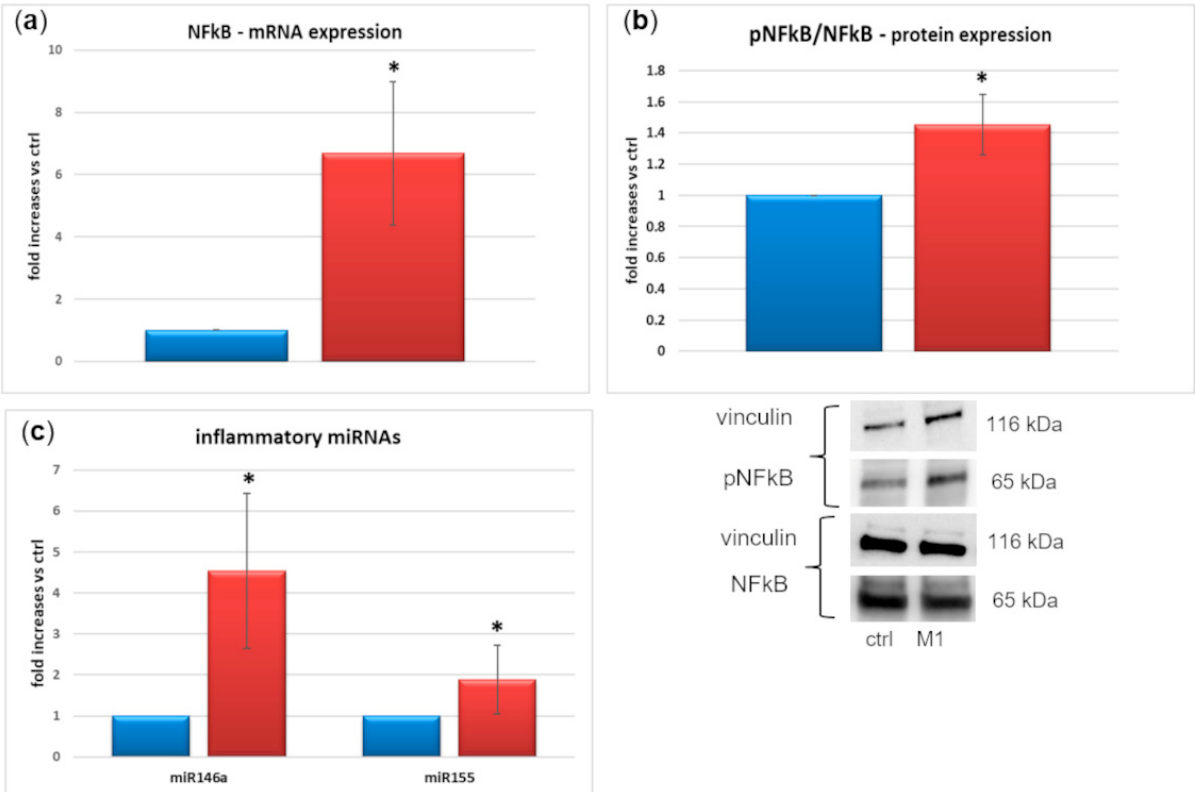
Figure 6. ( a ) Nuclear factor kappa B (NFkB) mRNA expression, mean of five experiments ±SD, * p < 0.05; ( b ) phospo-NFkB (pNFkB)/NFkB protein expression, mean of five experiments ±SD, * p < 0.05, plus representative images of one relevant Western blotting (WB) experiment; ( c ) inflammatory miRNAs 146a and 155 expression, mean of five experiments ±SD, * p < 0.05. Blue = control cells, red = M1-activated cells. M1 activation was achieved by exposing microglial cells for 24 h to TNF α 10